Question: Is the quantity shown trending increasing or decreasing?
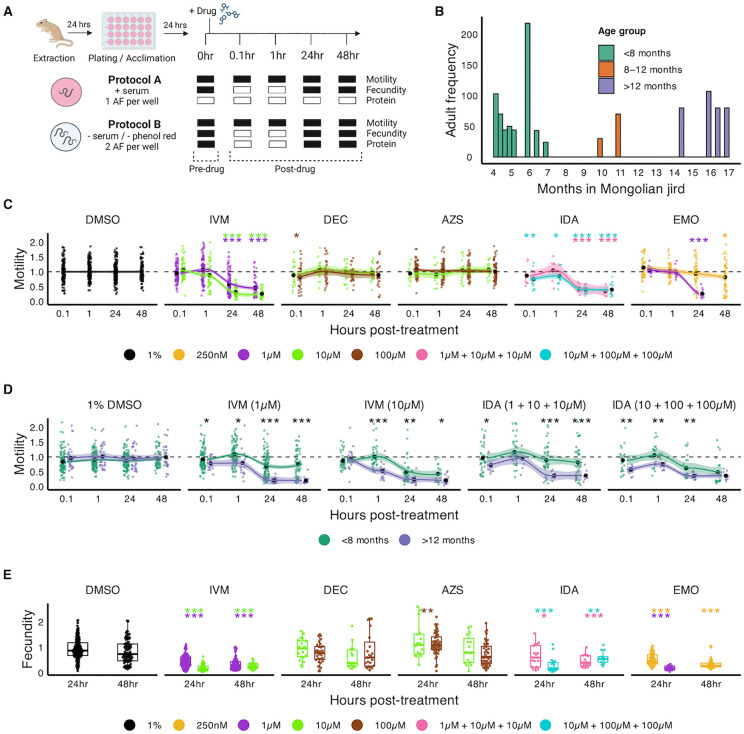
Answer: decreasing